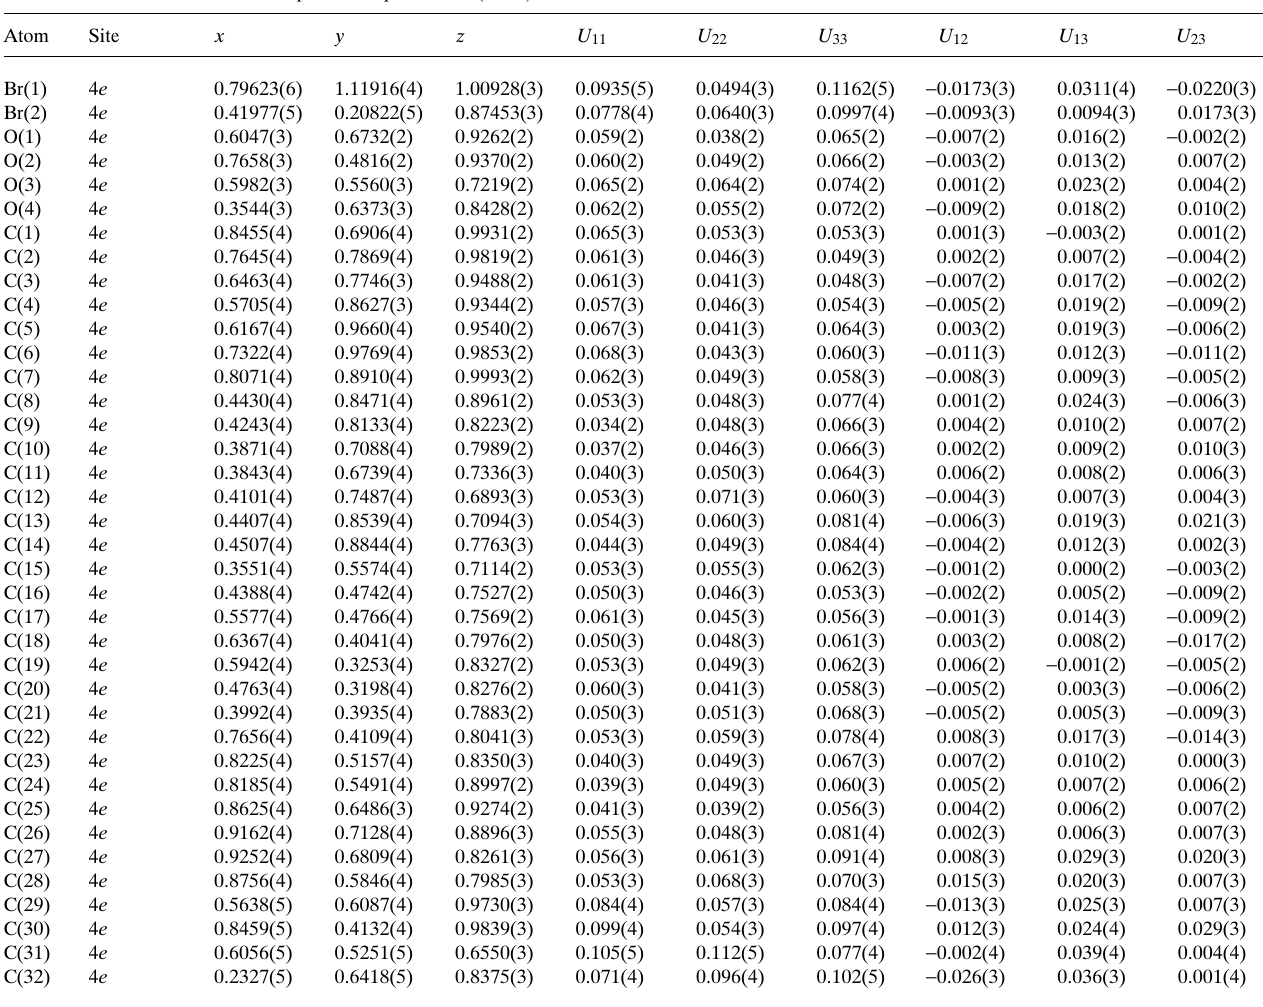
Table 3. Atomic coordinates and displacement parameters (in Å 2 )